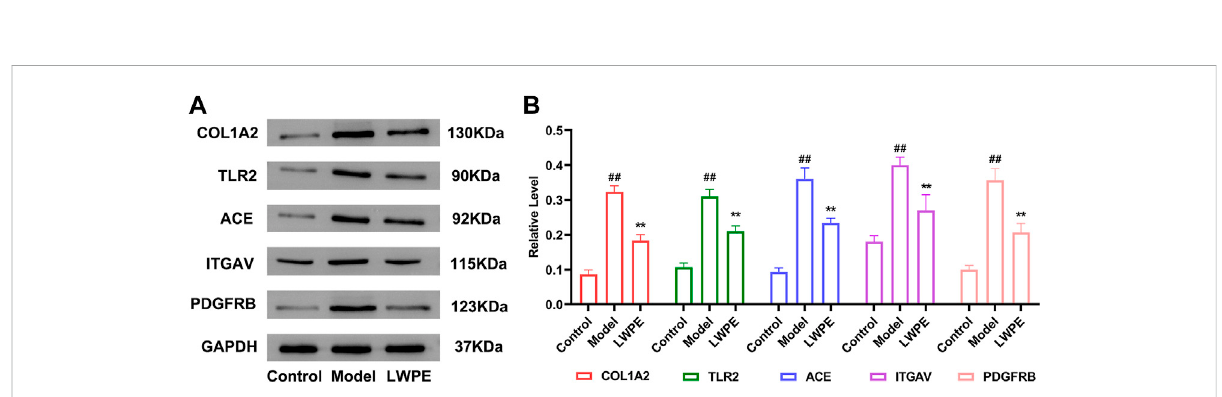
FIGURE 9 Western blot analysis of the key proteins. (A) The protein expression levels of GAPDH, COL1A2, ITGAV, TLR2, ACE and PDGFRB; (B) The relative levels of the proteins, in the model group vs the LWPE group. Data are expressed as the mean ± SEM ( n = 3). ## p < 0.01 vs the control group; * p < 0.05, ** p < 0.01 vs the model